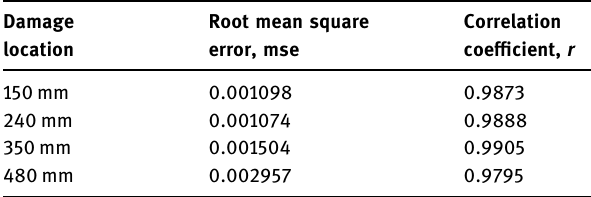
Table 1: Statistics of fi tness of various damages